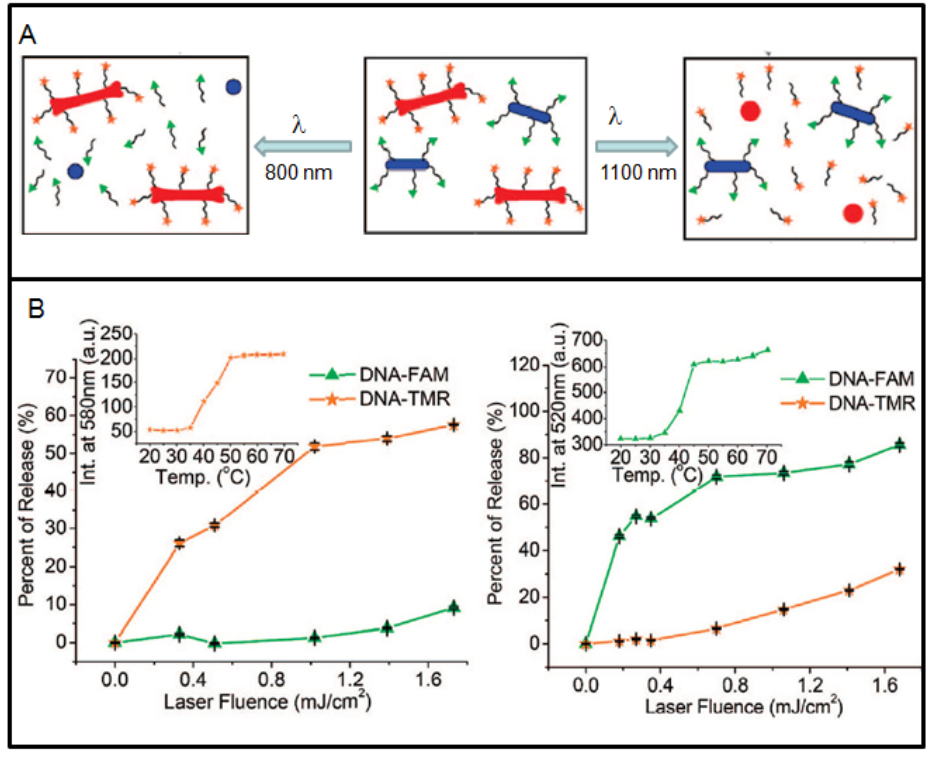
Figure 6. Use of gold nanorods (GNRs) for controlled delivery of drugs. ( A ) Schematic explaining the selective release. Laser irradiation of DNA-conjugated NRs (blue ovals) and irradiation (left), which melts the nanocapsules and NRs (red bones) are exposed to  800 selectively releases the conjugated DNA (labeled by FAM (green triangles)). Exposure to irradiation (right) melts the nanobones, selectively releasing the conjugated DNA  1100 (labeled by TMR (orange stars)). ( B ) DNA functionalization of NRs and selective release: Percent released of FAM-DNA (green triangles) and TMR-DNA (orange stars) as a and  laser fluence, respectively. Inset figures: melting curves of function of  800 1100 released DNA. Reproduced with permission